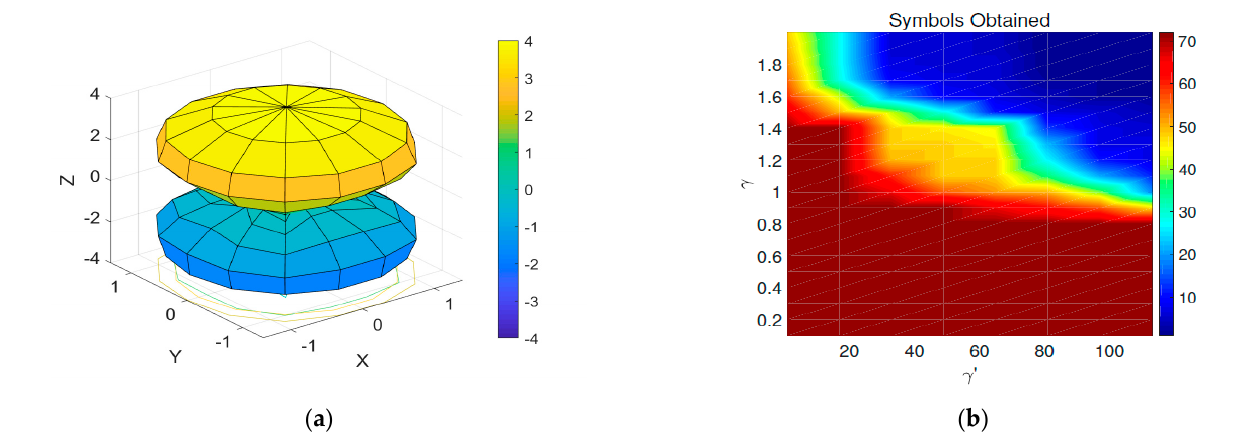
Figure 3. Measuring and coding information bits into radiation patterns. ( a ) Degraded radiation pattern gain (dBi) reconstruction assuming a limited resolution for symbol 00,000 shown in Figure 2. ( b ) Orthogonal symbols for an eight-antenna system with 𝜌 = 4 versus the parameters 𝛾 and 𝛾 (cid:4593) .